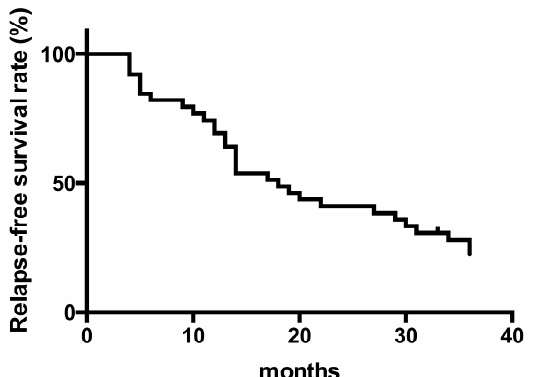
Figure 2. Kaplan–Meier plots for relapse-free survival of patients treated with tacrolimus for more than 3 months (n = 39).